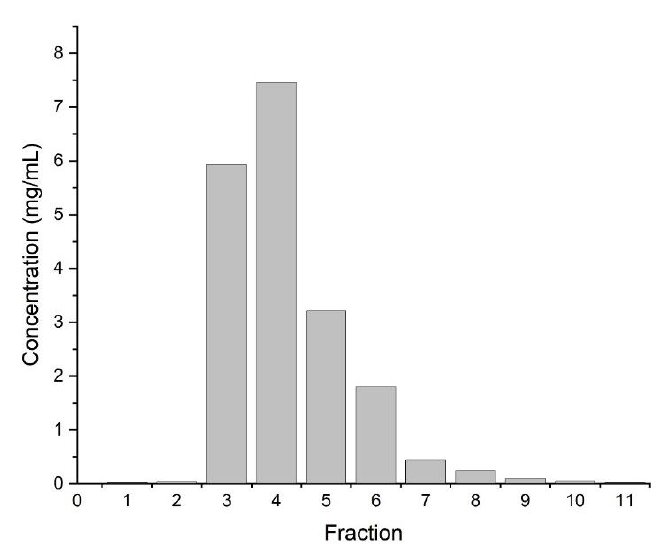
Figure 15. IgG concentrations were obtained directly by fractionation without an enrichment